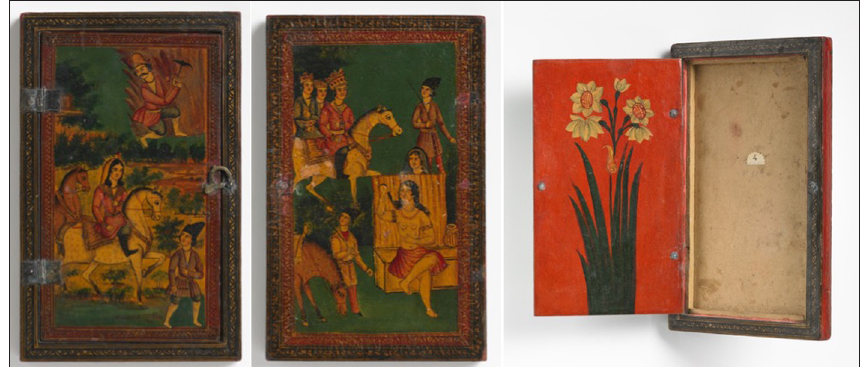
Fig. 7 : Mirror case, lacquer, Iran, nineteenth century. F65B, given by Miss E. G. Tanner in 1926. © Holburne Museum, Bath. Photo: <www.tonygilbert.co.uk>.